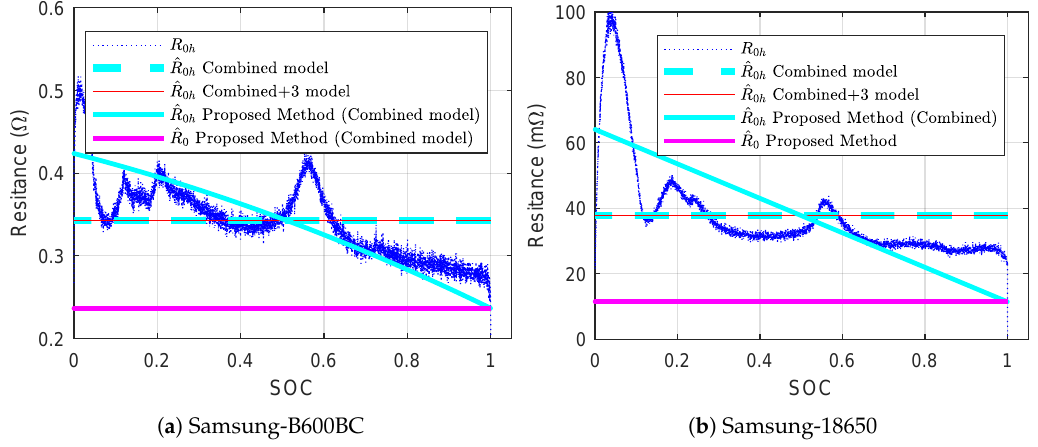
Figure 11. SOC vs. resistance estimation in ECM.